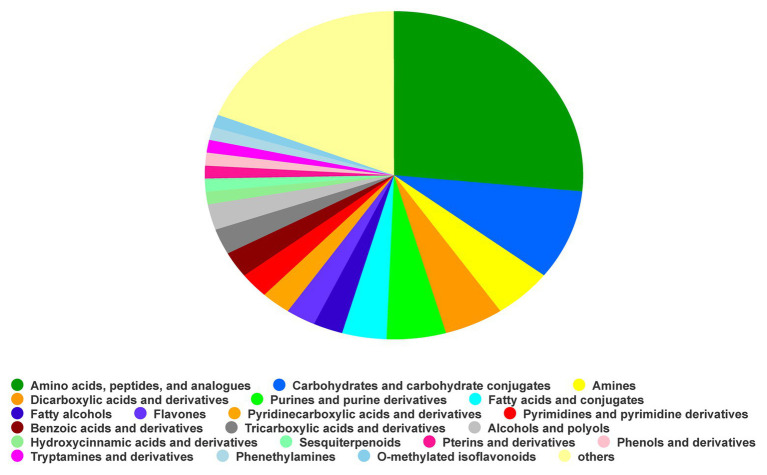
Compound classification based on HDBM.